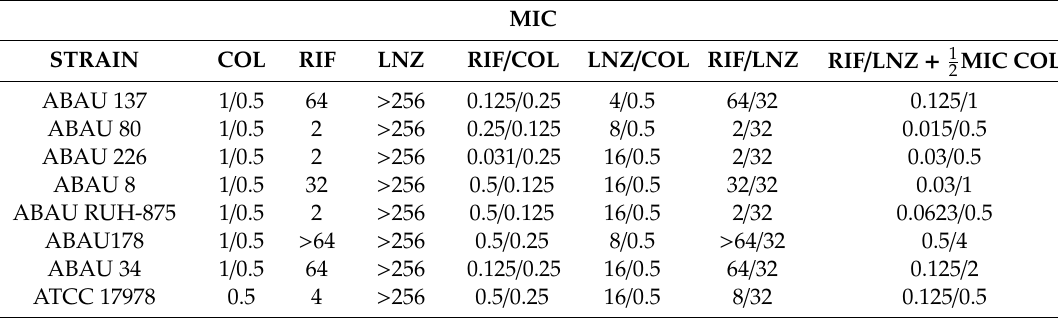
Table 5. MICs according to EUCAST [16] in MDR A. baumannii strains.